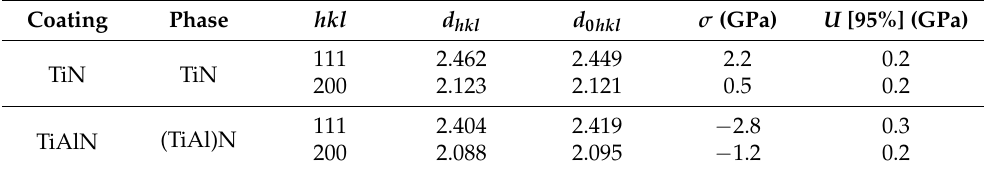
Figure 6. The representative XRD patterns of the MCT-TAN specimen. Table 3. The stress values, their measurement uncertainties, and supported